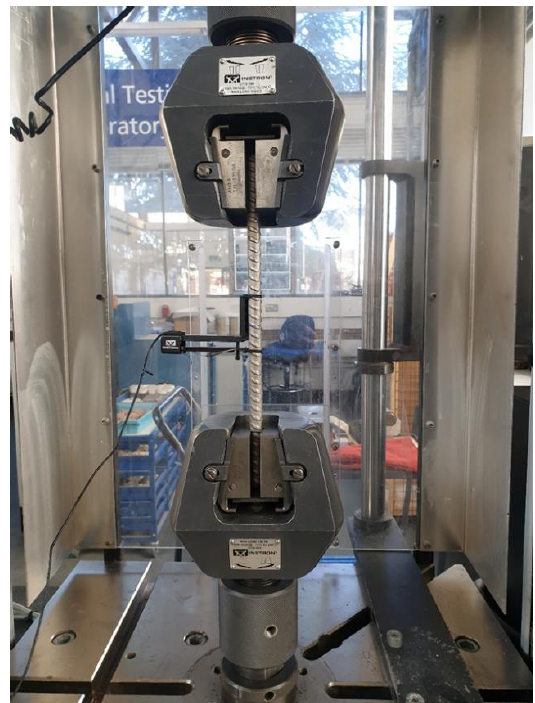
Figure 3. Set-up for tensile testing on Instron 5584.